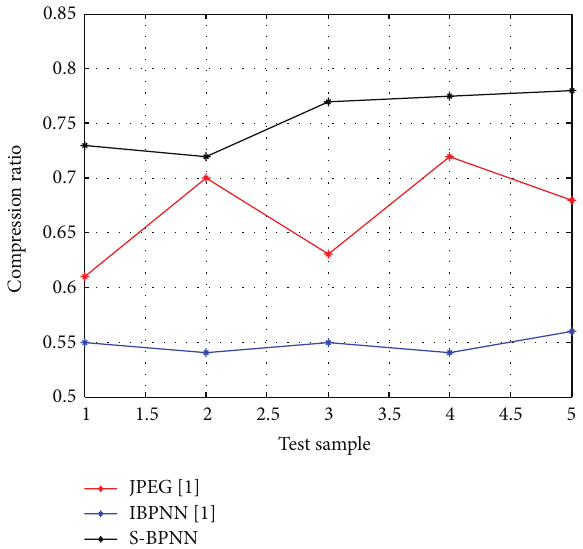
Figure5:Comparisonofcompressionratiowhenthethreemethods are applied.